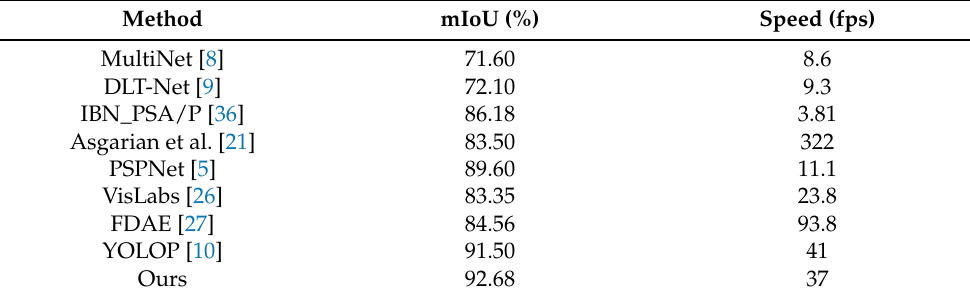
Table 1. Drivable area segmentation results on the BDD100K dataset.